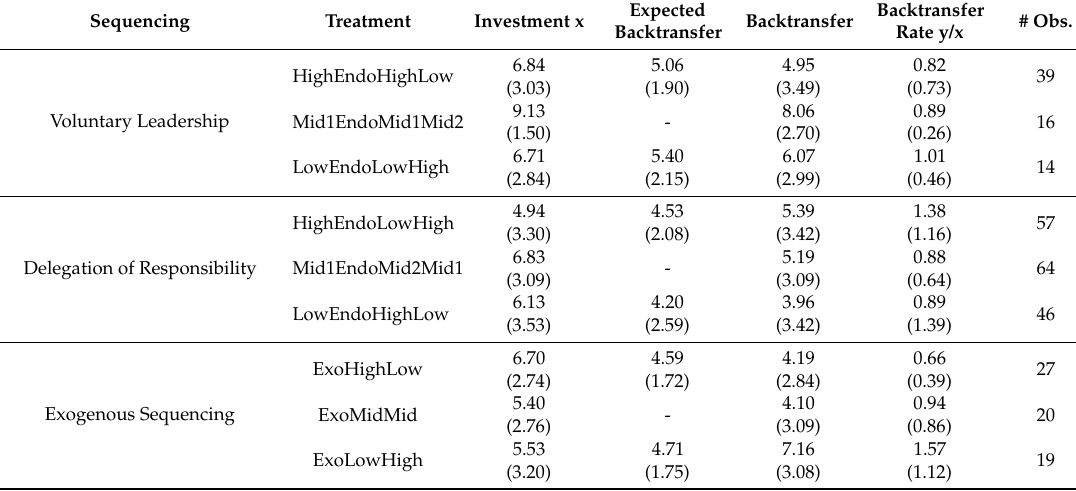
Table 2. Summary Statistics: Mean (Standard